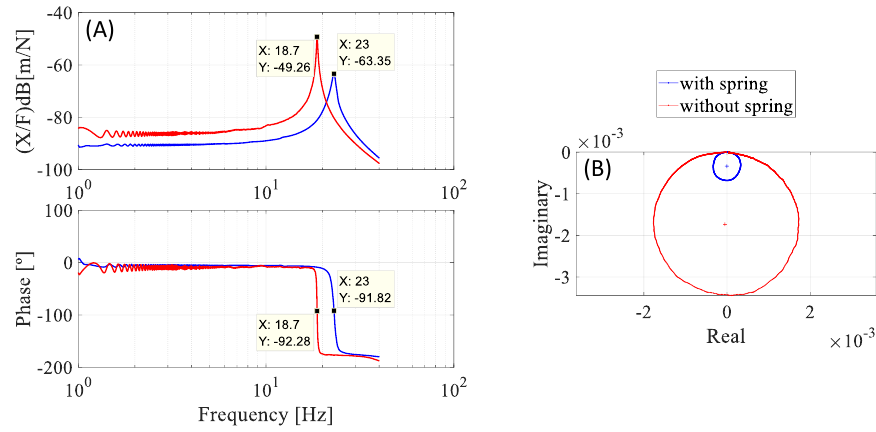
Figure 12. SEMD results of SMA-SE bending spring. ( A ) Bode plots; ( B ) Nyquist plots. Table 4. Hysteresis damping, stiffness, and loss factor obtained from SEMD. A B SDOF without SDOF with Unit M-Shape Device M-Shape Device 289.25 1485.7 N/m